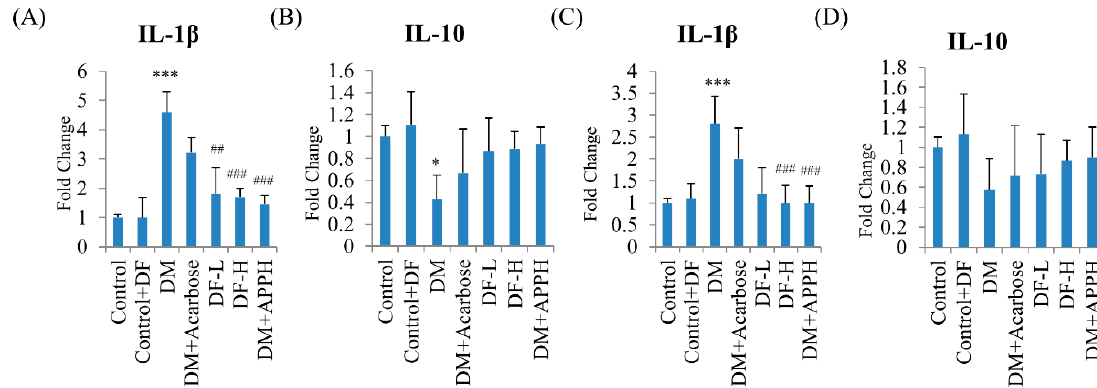
Figure 6. DF suppressed modulated inflammatory cytokines in DM mice. ELISA assay of the pancreatic ( A , B ) and the serum ( C , D ) levels of IL-1 β ( A , C ) and IL-10 in non-diabetic controls (Control), non-diabetic mice treated with DF (Control+DF), STZ-induced diabetes mellitus mice (DM), DM mice treated with acarbose (DM+Acarbose), DM mice treated with low-dose DF peptide (DM+DF-L), DM mice treated with high-dose DF peptide (DM+DF-H), and DM mice treated with APPH peptide (DM+APPH). * = p < 0.05 and *** = p < 0.001 indicate significant difference with respect to the control group; ## = p < 0.01 and ### = p < 0.001 indicate significant difference with respect to the DM group